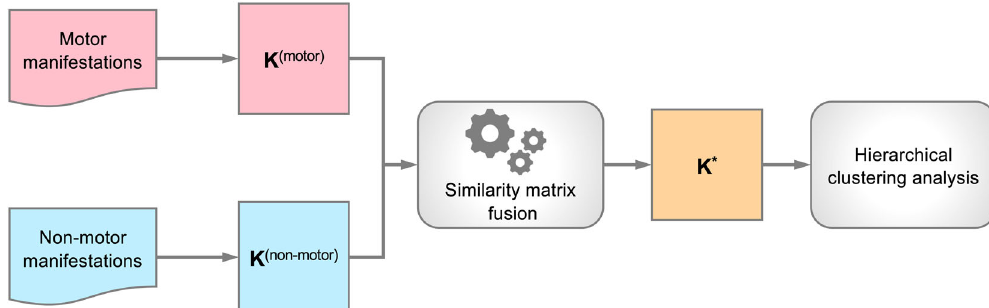
Fig. 2 Overall work fl ow of PD subtyping. Two patient similarity matrices ( K (motor) and K (non-motor) ) were fi rst derived using motor and non- motor manifestation data, respectively. Then our similarity matrix fusion algorithm was performed to produce integrated similarity matrix (i.e., K*). Finally, hierarchical clustering analysis was applied to K* to identify PD